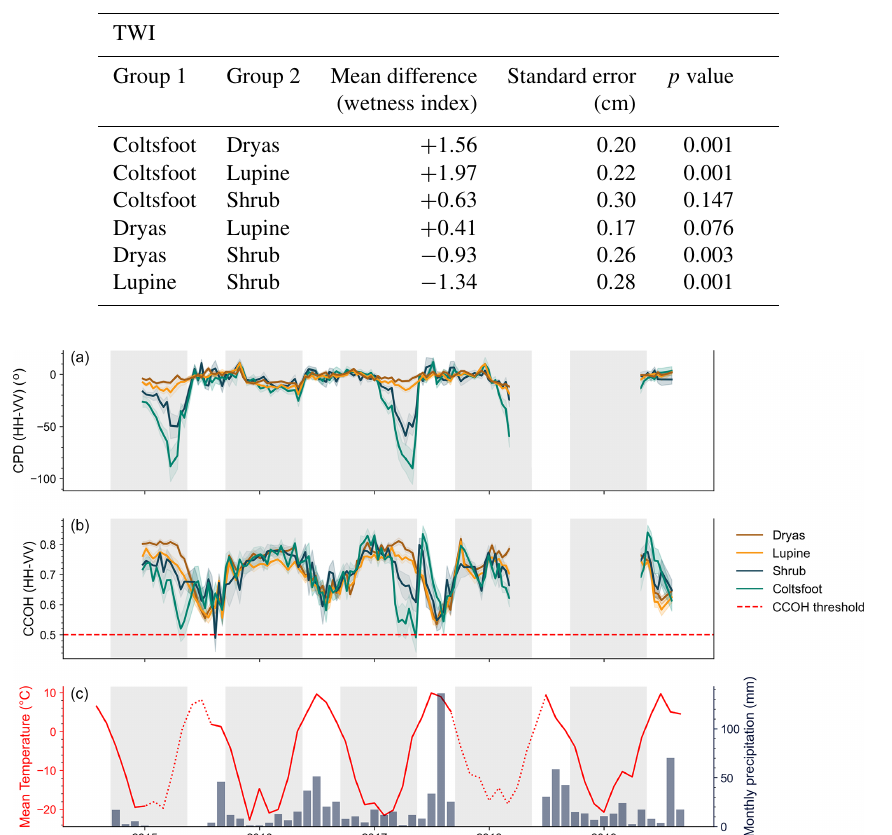
Figure 5. (a) Average CPD and (b) average CCOH by vegetation class with interval of confidence (95%) for orbit 24 (31 ◦ , descending). Values were extracted from the GPS dataset (see Fig. 2c), in which N Coltsfoot = 33, N Dryas = 140, N Lupine = 118 and N Shrub = 29. The winter period (mid-September to mid-May) is shown in the shaded area. The window over which vegetation class information was extracted is the same size as a TSX pixel (5 × 5m). (c) Meteorological data from Qikiqtaruk/Herschel Island station (dataset from Environment Canada, 2021). The meteorological station is not equipped with a telemetry system, and since the island is inaccessible during the winter, the lack of data during the winters of 2014–2015 and 2017–2018 was caused by a malfunction at the station. Air temperatures during these periods were gap-filled using Komakuk Beach meteorological station and are shown by the dotted red line. Please refer to Appendix A for further details on the